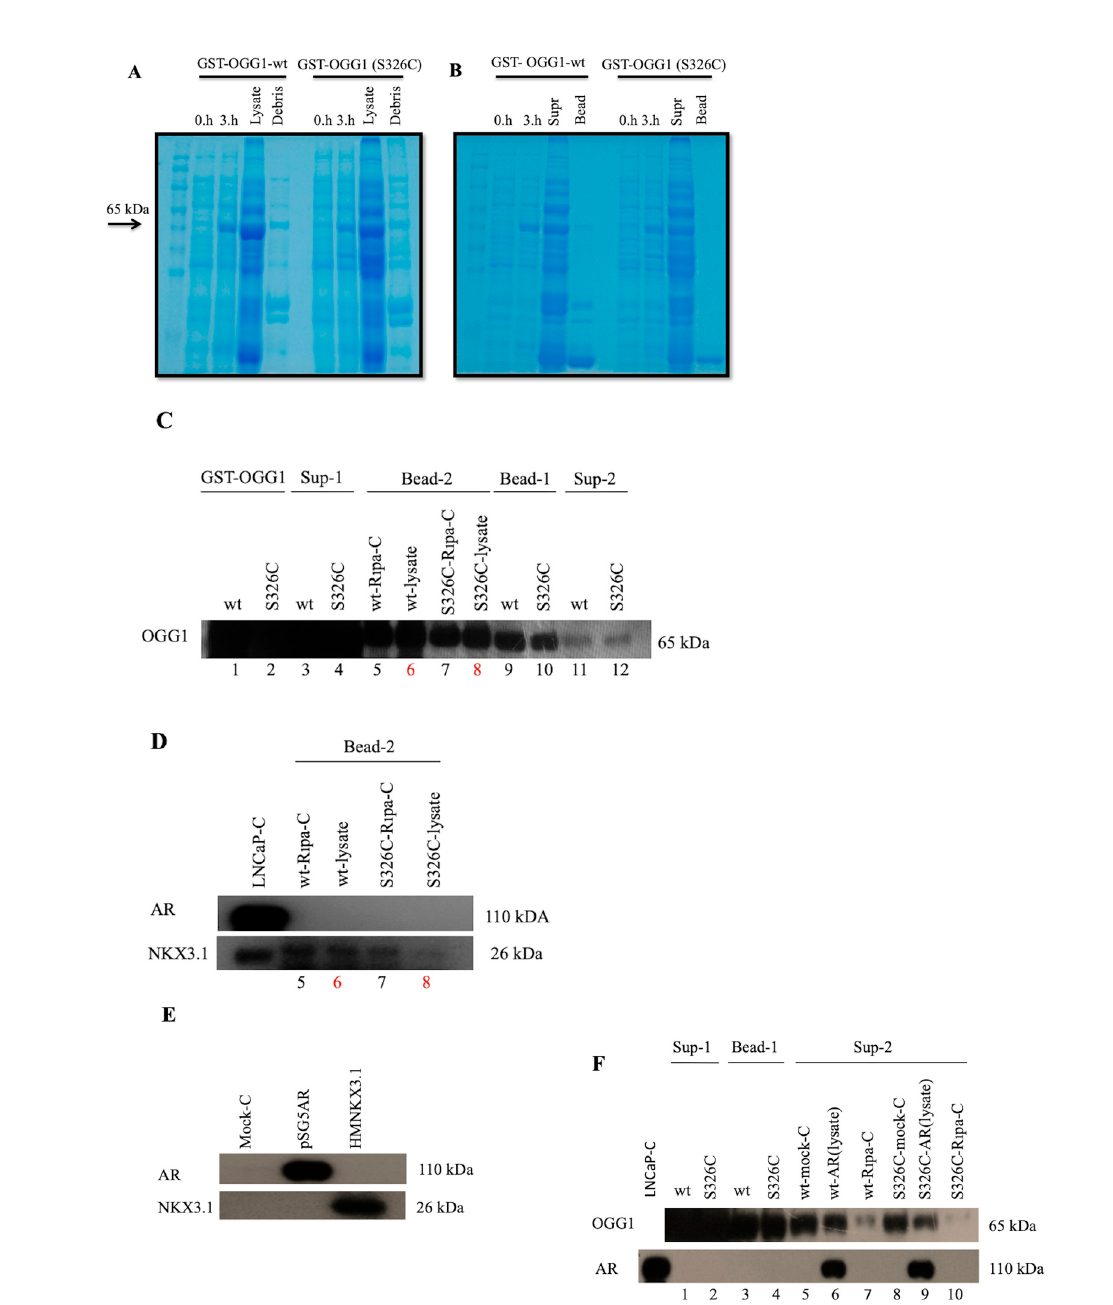
lysates (Figure 2B) and checked by OGG1 antibody labeling (Figure 2C), it was positive whereas AR was not observed in samples 6 and 8. Therefore, we concluded that OGG1-AR interaction was not positive. In the NKX3.1 antibody labeling, there was a significant band in samples 6 and 8, however, non-specific NKX3.1 bands in negative controls were also observed so that the bands did not indicate the specific interactions (Figure 2D). Therefore the conclusion was also negative for both protein interactions